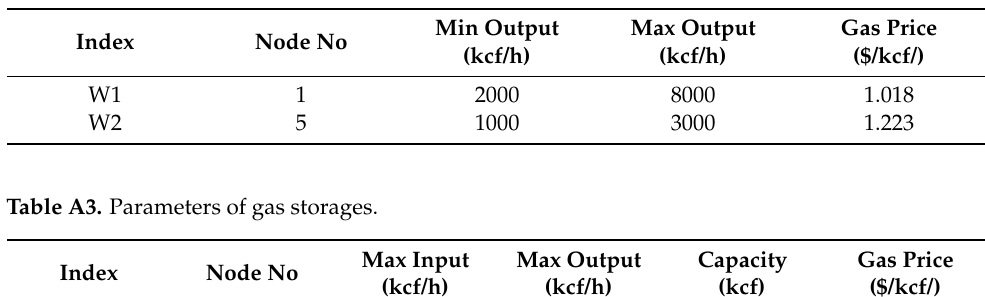
Table A2. Parameters of gas wells.